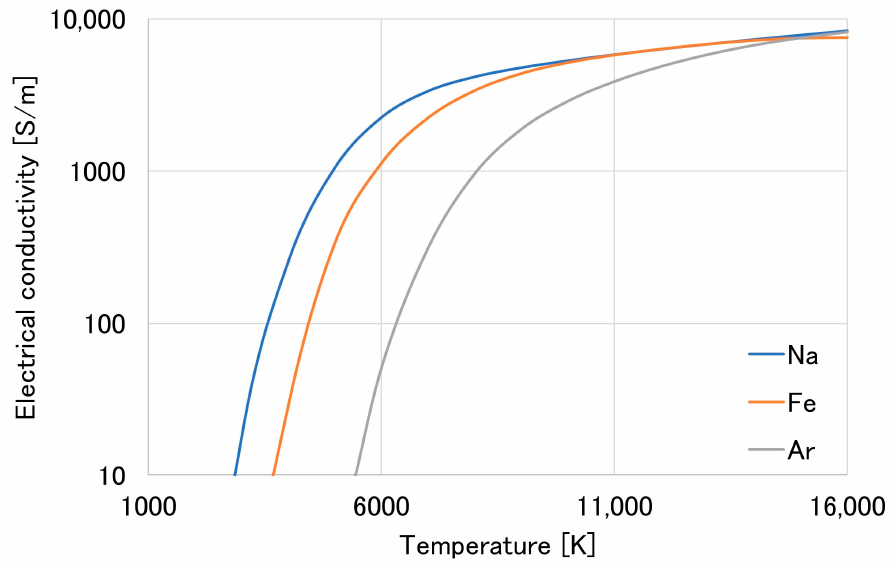
Figure 9. Electrical conductivity of sodium (Na), iron (Fe), and argon (Ar) plasma.